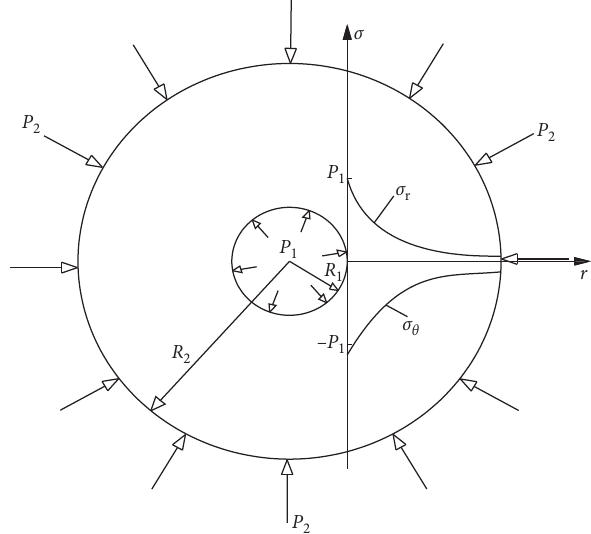
Figure 11: Schematic diagram of the stress on the borehole and the surrounding